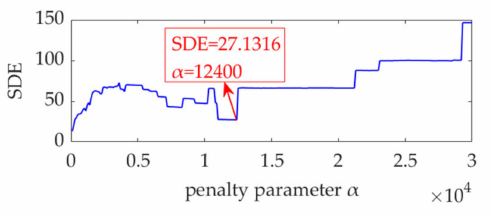
Figure 15. Relationship between the penalty parameter, α , and SDE